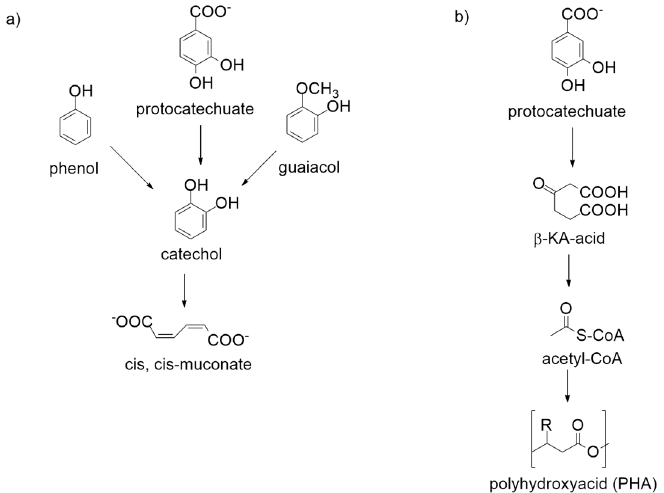
Figure 5. Production of ( a ) cis , cis -muconate and ( b ) polyhydroxyacid (PHA) by aerobic microbial metabolism. Adapted with permission from [32]. Copyright 2014, National Academy of Science.